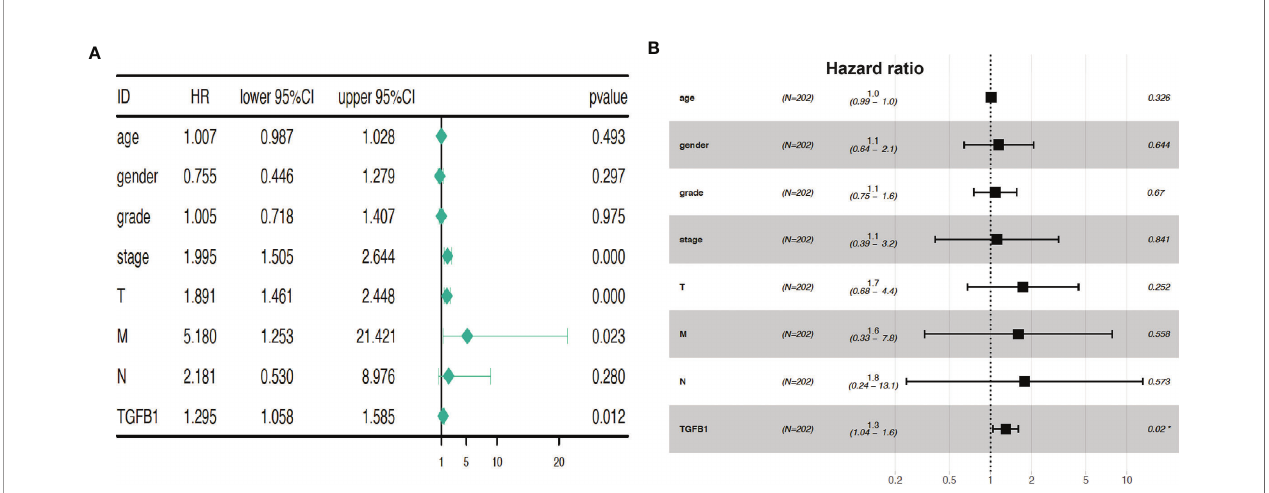
FIGURE 3 | TGF- b 1 expression is a prognostic factor for HCC progression. Univariate Cox regression analysis (A) and multivariate Cox regression (B) demonstrated that TGF- b 1 could be a prognostic factor of HCC. Hazard ratio was computed using survival, survminer, and forestplot packages. HR, hazard ratio; CI, con fi dence intervals; T, tumor; M, metastasis; N, (lymph) node. p < 0.05, p < 0.01, and p < 0.001 suggest signi fi cance, strong signi fi cance, and extremely strong signi fi cance,